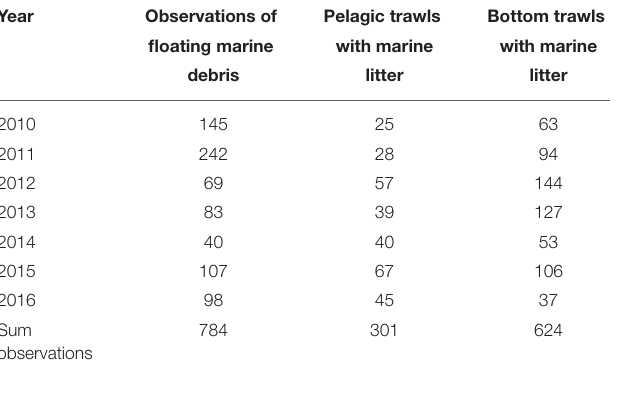
TABLE 1 | Number of observations of floating marine debris and number of trawls, where any kind of marine litter observed given for each years and sum for the studied period 2010–2016.